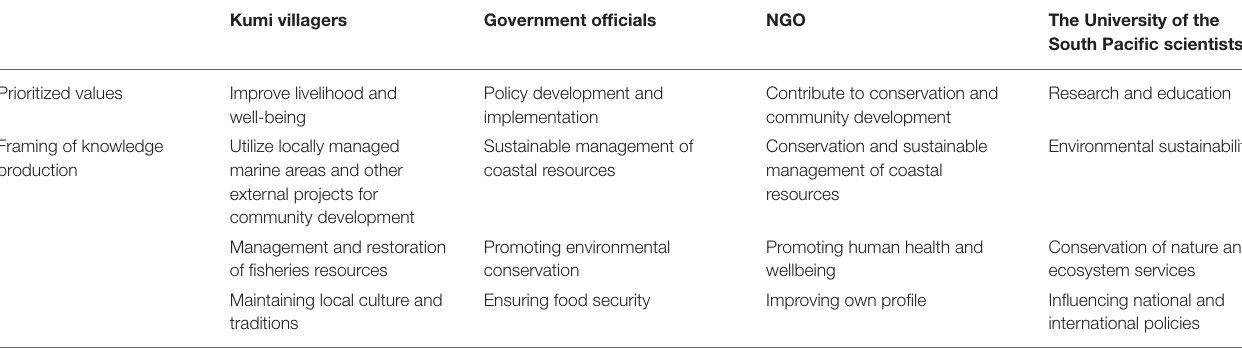
TABLE 2 | Prioritized values and framing of knowledge productions among diverse stakeholder groups working in Kumi